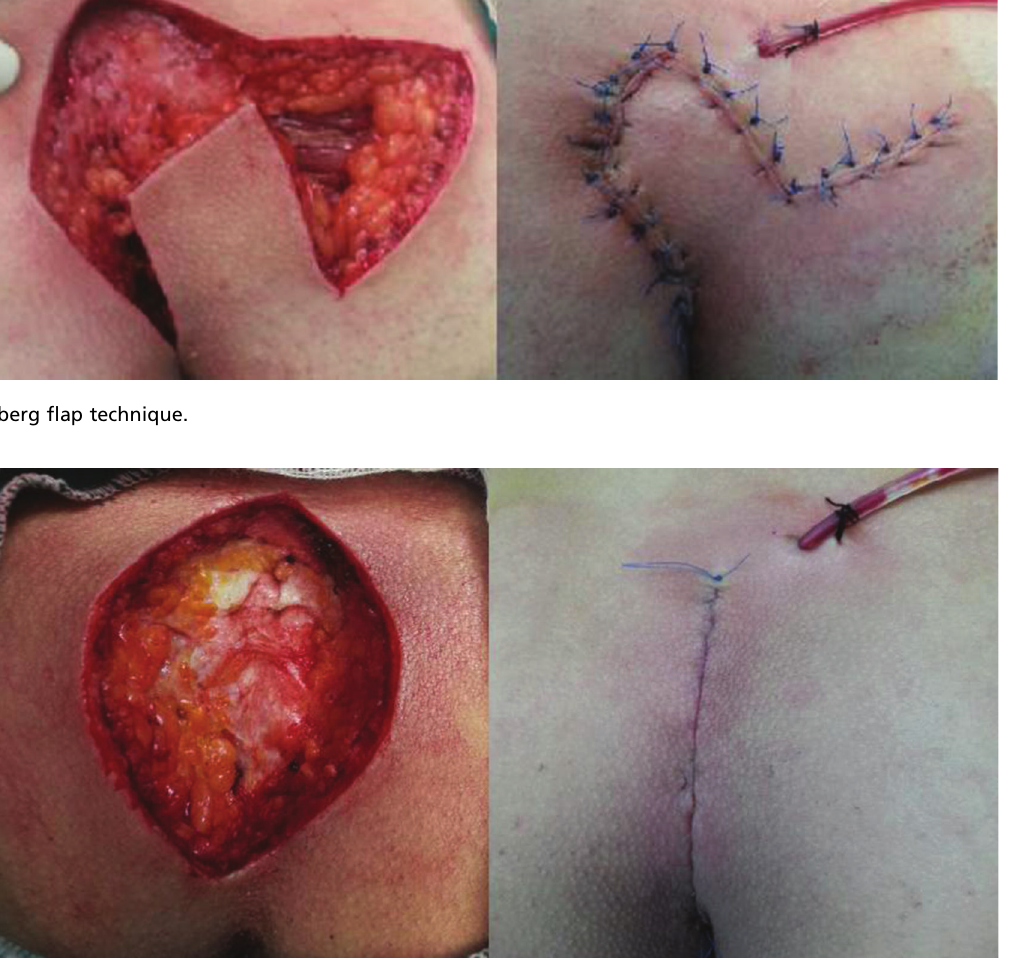
Figure 3 - Karydakis flap